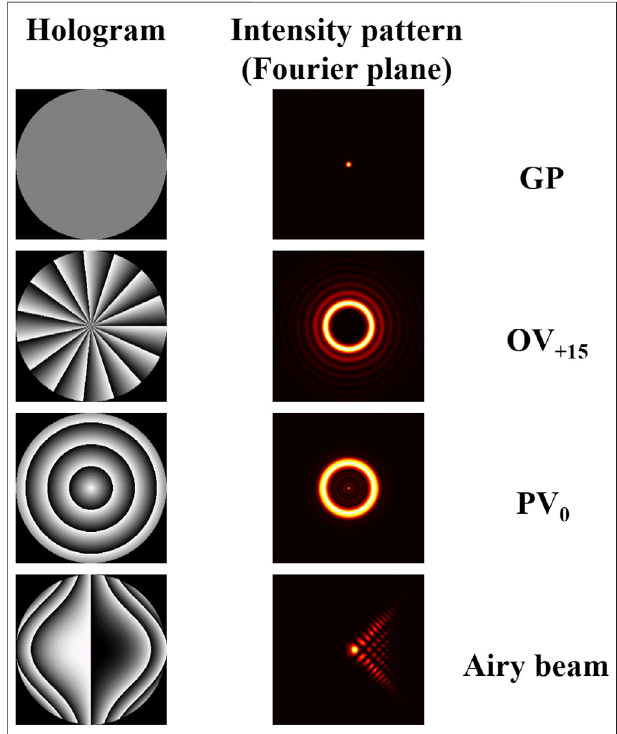
FIGURE 2 | Holograms and intensity patterns of the Gaussian point (GP), optical vortex (OV +15 ), perfect vortex (PV 0 ), and Airy